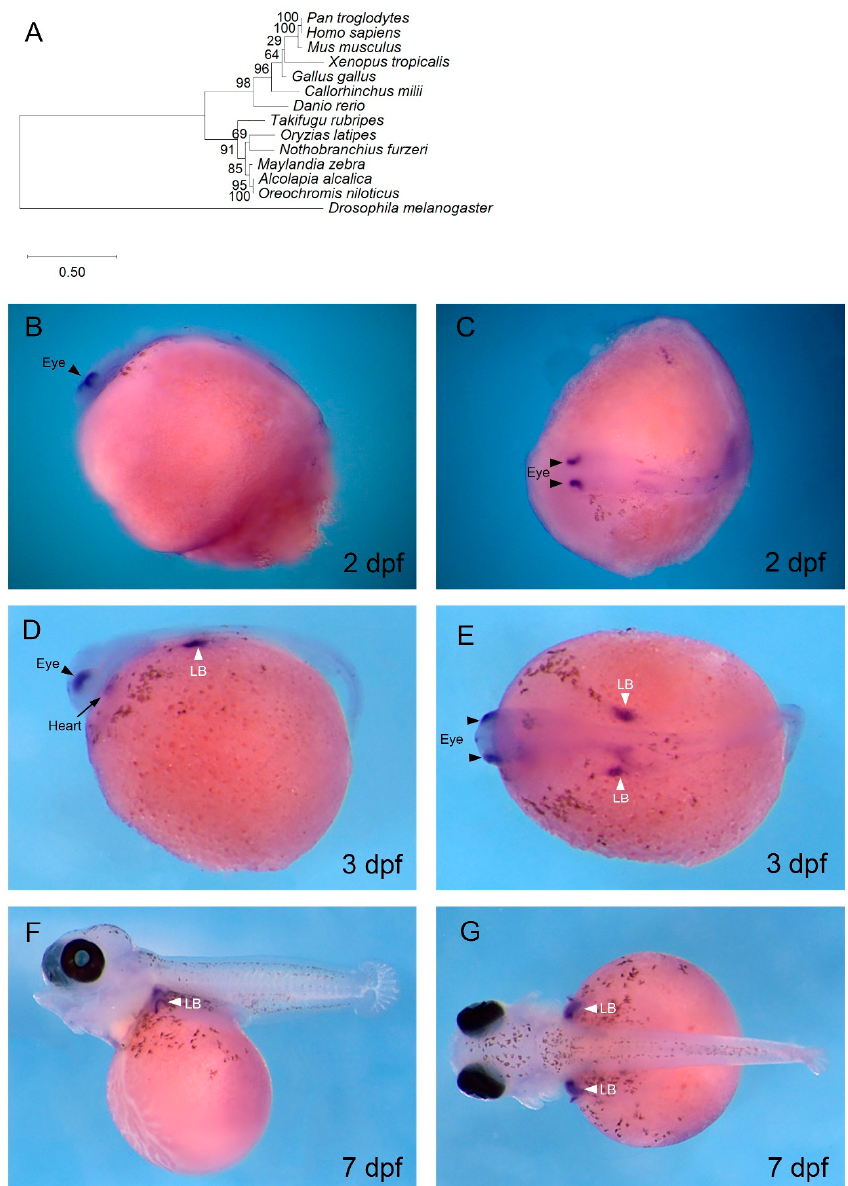
Figure 3. tbx5 expression in O. alcalica dorsal retina, heart, and pectoral limb buds. ( A ) Phylogenetic analysis of Tbx5. The evolutionary history was inferred using the maximum likelihood method and Jones with frequency model [64]. ( B – G ) In situ hybridisation of O. alcalica tbx5 at 2 days post fertilisation (dpf) ( B , C ), 3 dpf ( D , E ), and 7 dpf ( F , G ). At 2 dpf, tbx5 was expressed in the dorsal region of the eye ( B , C ). At 3 dpf, tbx5 was expressed in the eye, heart, and limb bud (LB) ( D , E ). At 7 dpf, tbx5 was expressed in the LB ( F , G ). Black arrows denote the heart, black arrowheads mark the eyes, and white arrowheads denote the limb buds (LB). ( B , D , F ) Lateral views; anterior to the left. ( C , E , G ) Dorsal views; anterior to the left.